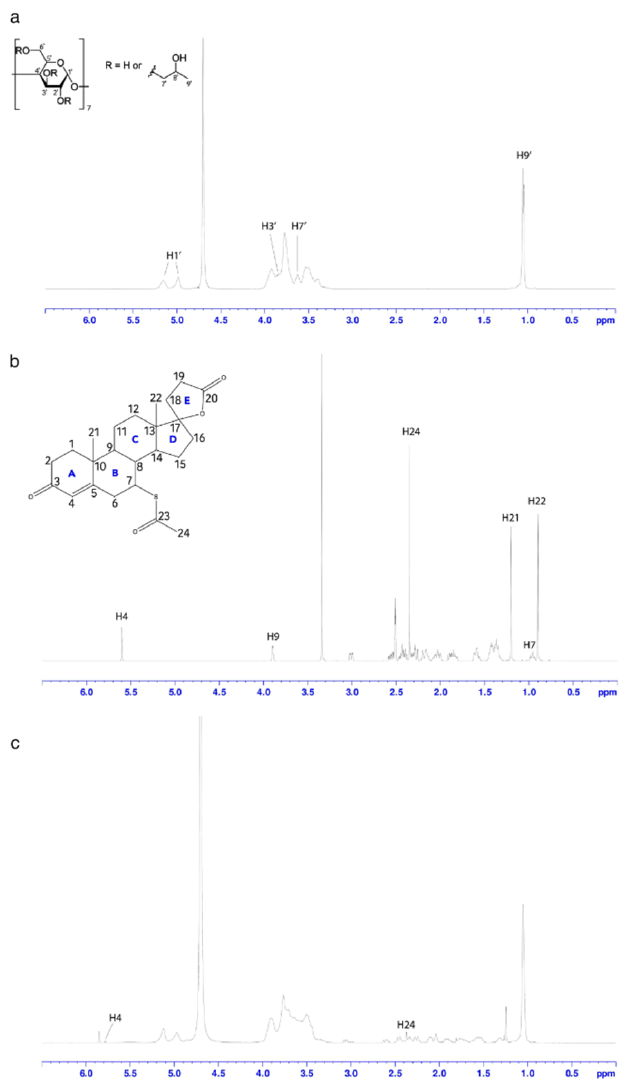
Figure 2 . Chemical structure (with carbons numbered) and 1 H NMR spectrum of ( a ) HP- β -CyD; ( b ) SPL; ( c ) SPL: HP- β -CyD mixture at 1:1 molar ratio.